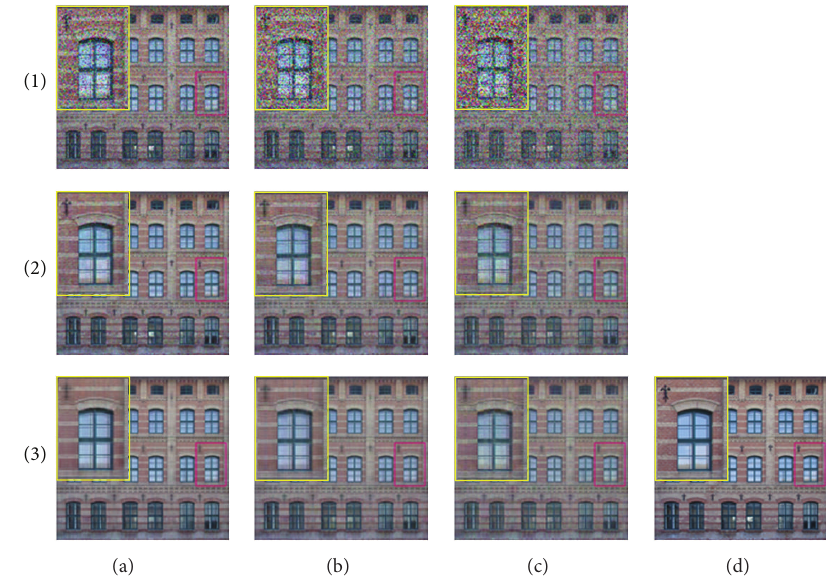
Figure 1: Comparisons in terms of visual effects. The rows (1) , (2) , and (3) correspond to the images before recovery, the obtained results by MALM-TR and RSTD [12], respectively. The columns (a), (b), and (c) correspond to the images corrupted by 15%, 25%, and 35% sparse impulsive noise, respectively. (d) is the original image.